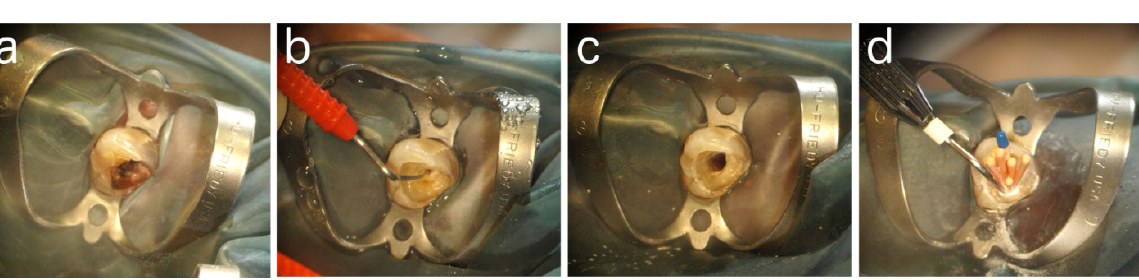
Figure 1. ( a ) Before pulpectomy of left maxillary canine; ( b ) Dental pulp exposure after removal of infected dentin; ( c ) Root canal after preparation and irrigation; ( d ) Root canal